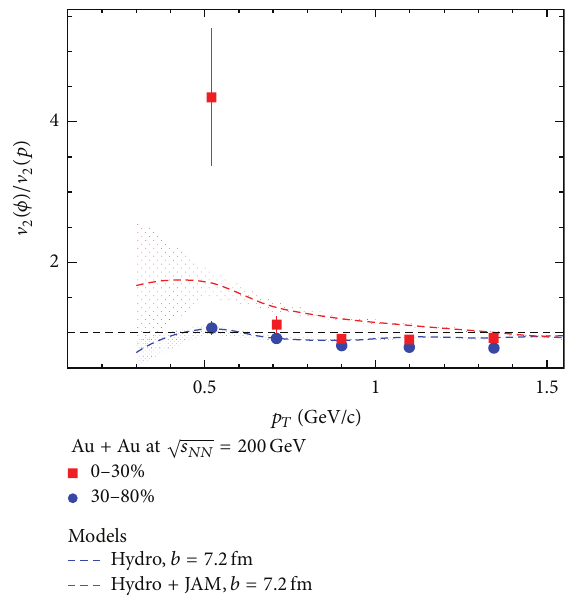
Figure 13: The 𝑝 𝑇 integrated proton and 𝜙 meson V 2 for various Figure 14: Ratio between 𝜙 and 𝑝 V 2 for 0–30% and 30–80% centre-of-mass energies for 0–80% centrality in Au + Au collisions centrality in Au + Au collisions √𝑠 𝑁𝑁 = 200 GeV [29, [32]. Vertical lines are the statistical error and systematic errors are shown by cap symbol. For lower RHIC energies, STAR preliminary 𝜙 and proton ⟨ V ⟩ calculation [17, 33, 34]. 𝑝 𝑇 spectra were used for 2 The red and blue lines are the fit to the 𝜙 and proton V 2 by empirical function just to guide the eye of the reader.